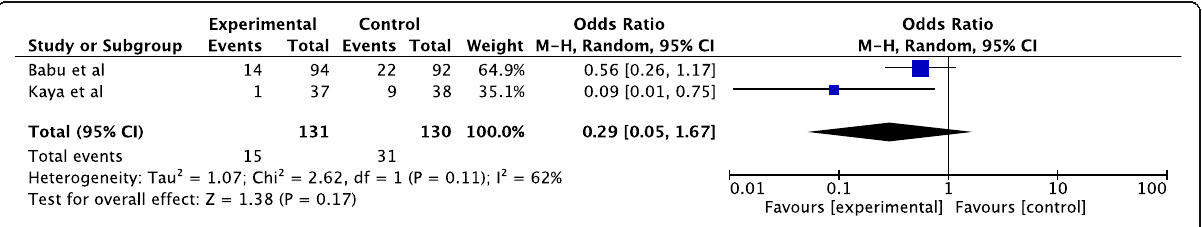
Fig. 7 Forest plot of reoperation rate in the included